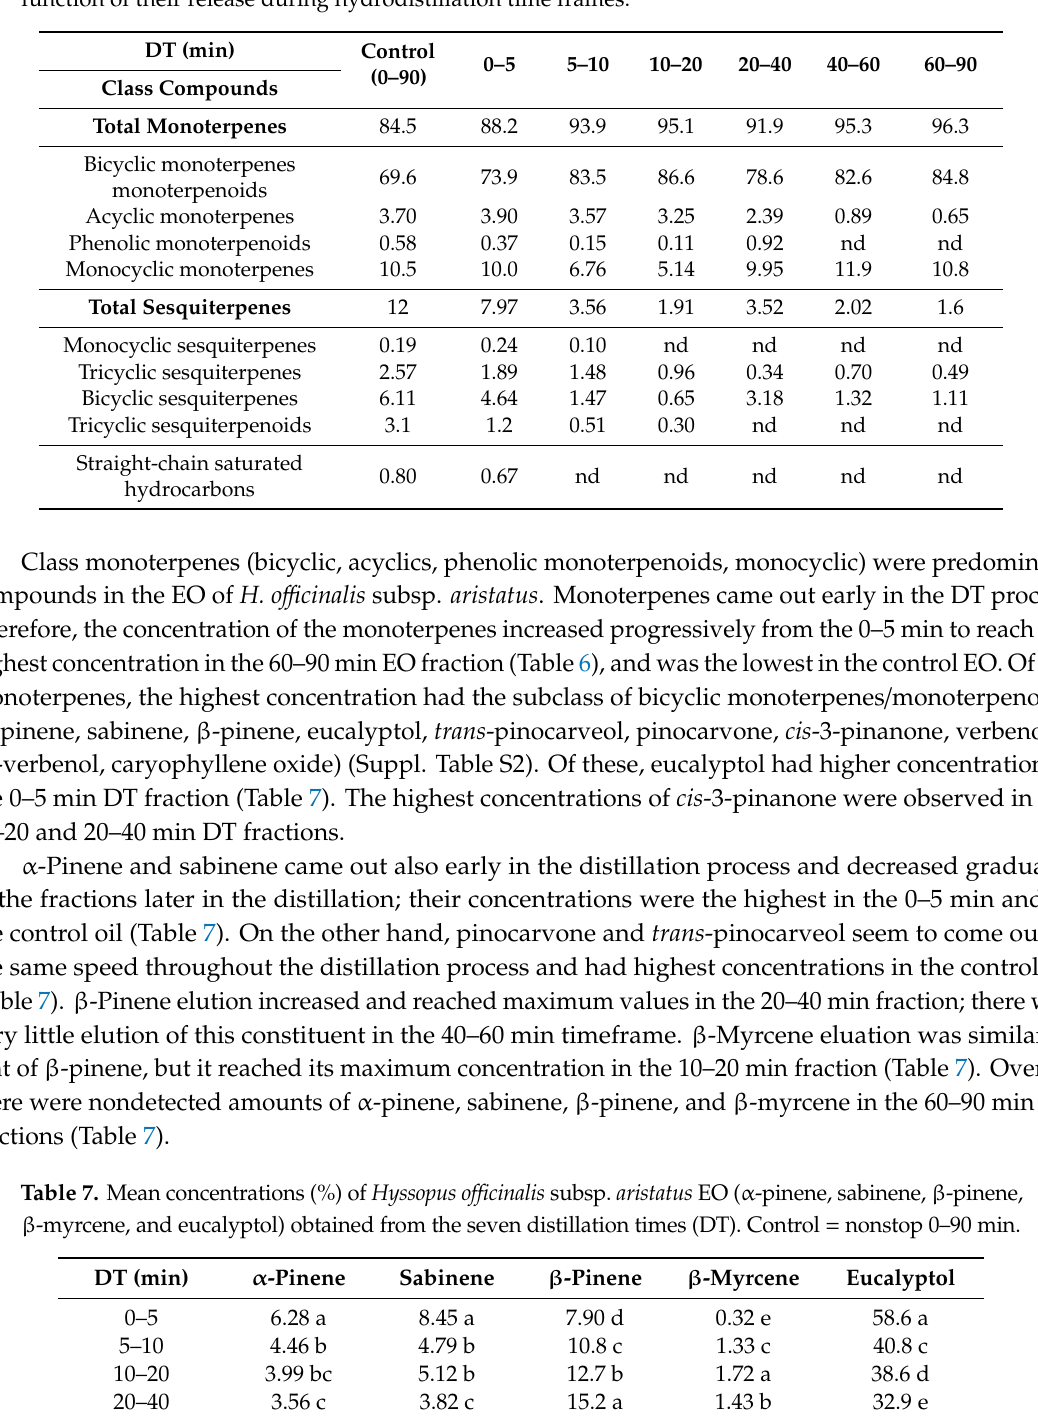
Table 6. Chemical families of Hyssopus o ffi cinalis subsp. aristatus essential oil (EO) constituents as a function of their release during hydrodistillation time frames.